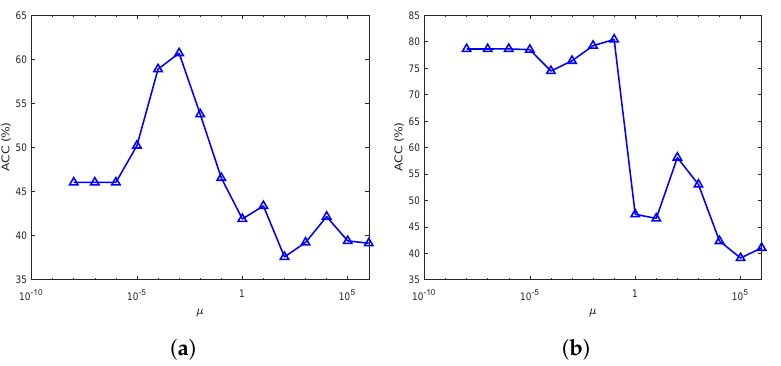
Figure 4. ACC (%) versus parameters µ of the proposed method on the ( a ) BBCSport dataset with 20% observed paired samples, ( b ) MSRC-v1 dataset with 30% missing instances of each view.